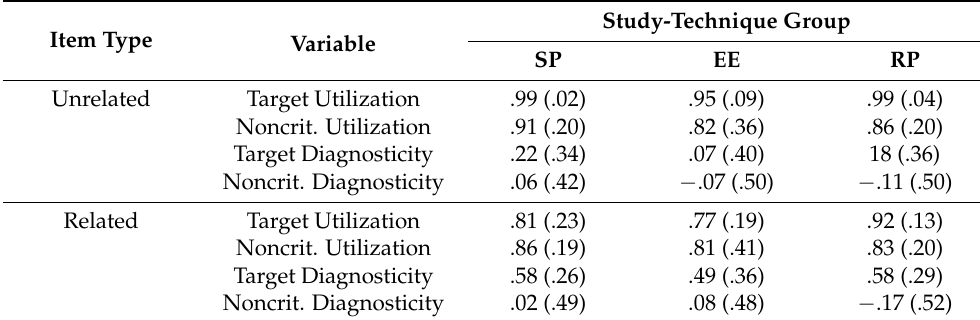
Table 4. Mean utilization and diagnosticity of target retrieval and noncriterial